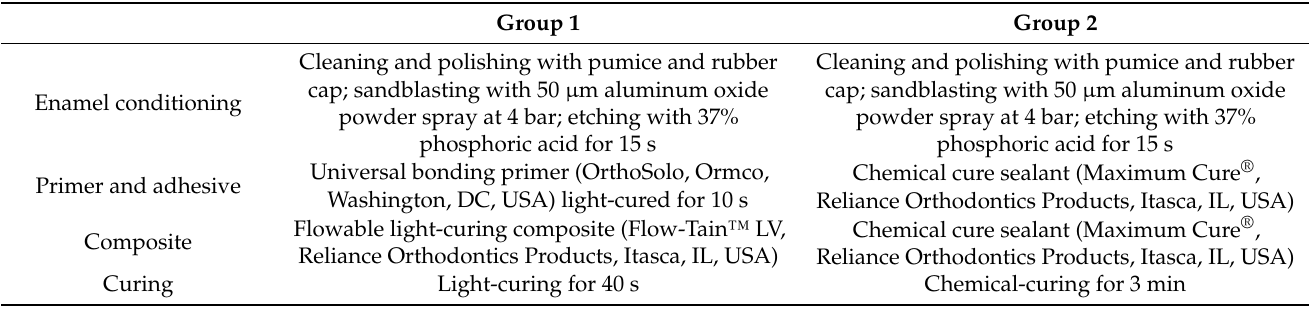
Table 1. Bonding procedures for the two groups.